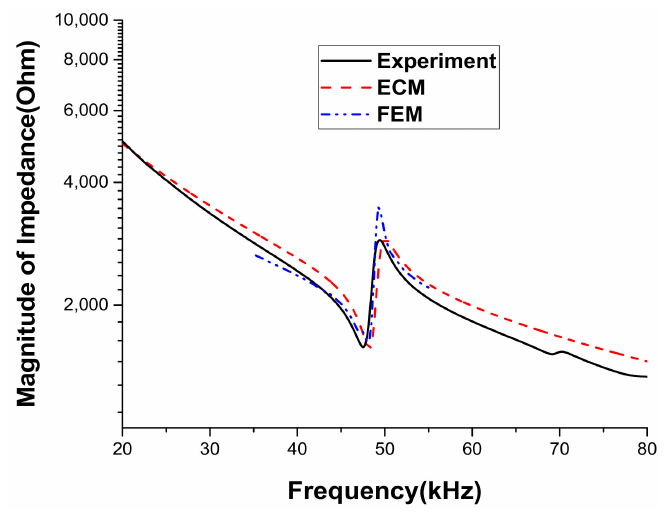
Figure 12. Comparison of the impedance spectra of the ultrasonic sensor obtained by different methods.